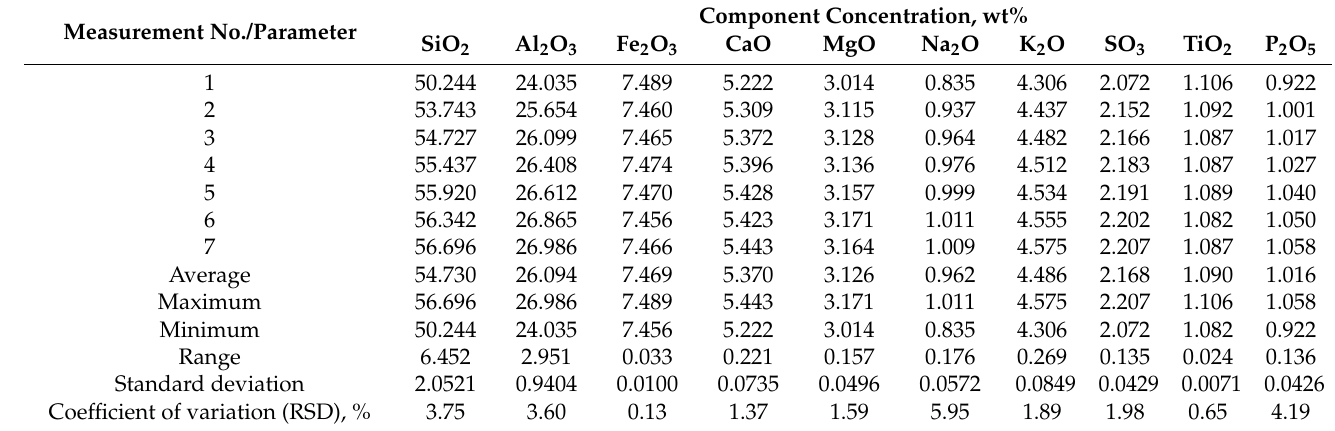
Table 2. Results of 7-fold X-ray measurement of 1 tablet prepared from a test coal ash sample.